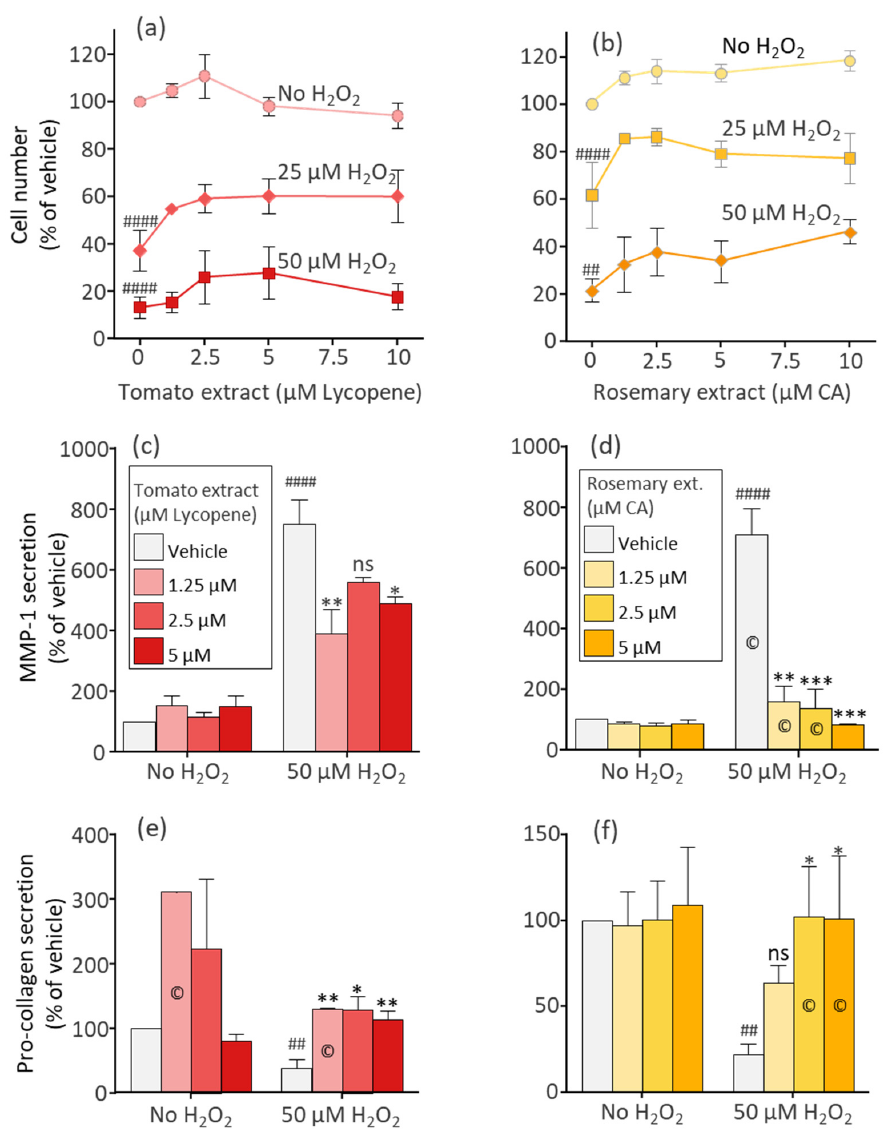
Figure 2. Tomato and rosemary extracts protect fibroblasts from H 2 O 2 -induced cell damage. NHDF cells were pre-incubated for 24 h with tomato extract or rosemary extract at the indicated concentra- tions of lycopene or carnosic acid, respectively. Then, H 2 O 2 was added at the indicated concentrations for an additional 24 h. The cell number ( a , b ), and secretion of MMP-1 ( c , d ) and pro-collagen 1a1 ( e , f